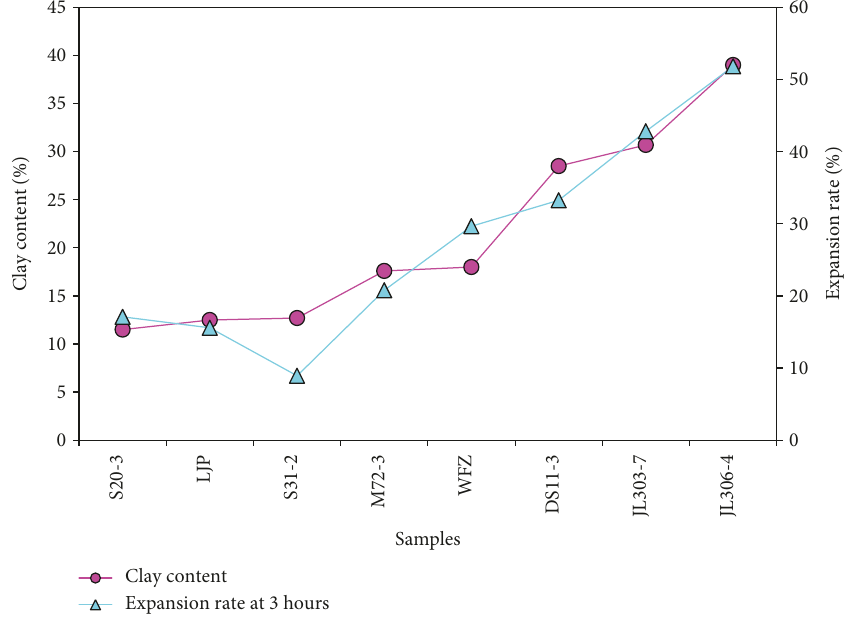
Figure 13: The relationship between expansion rate at 3 hours and clay